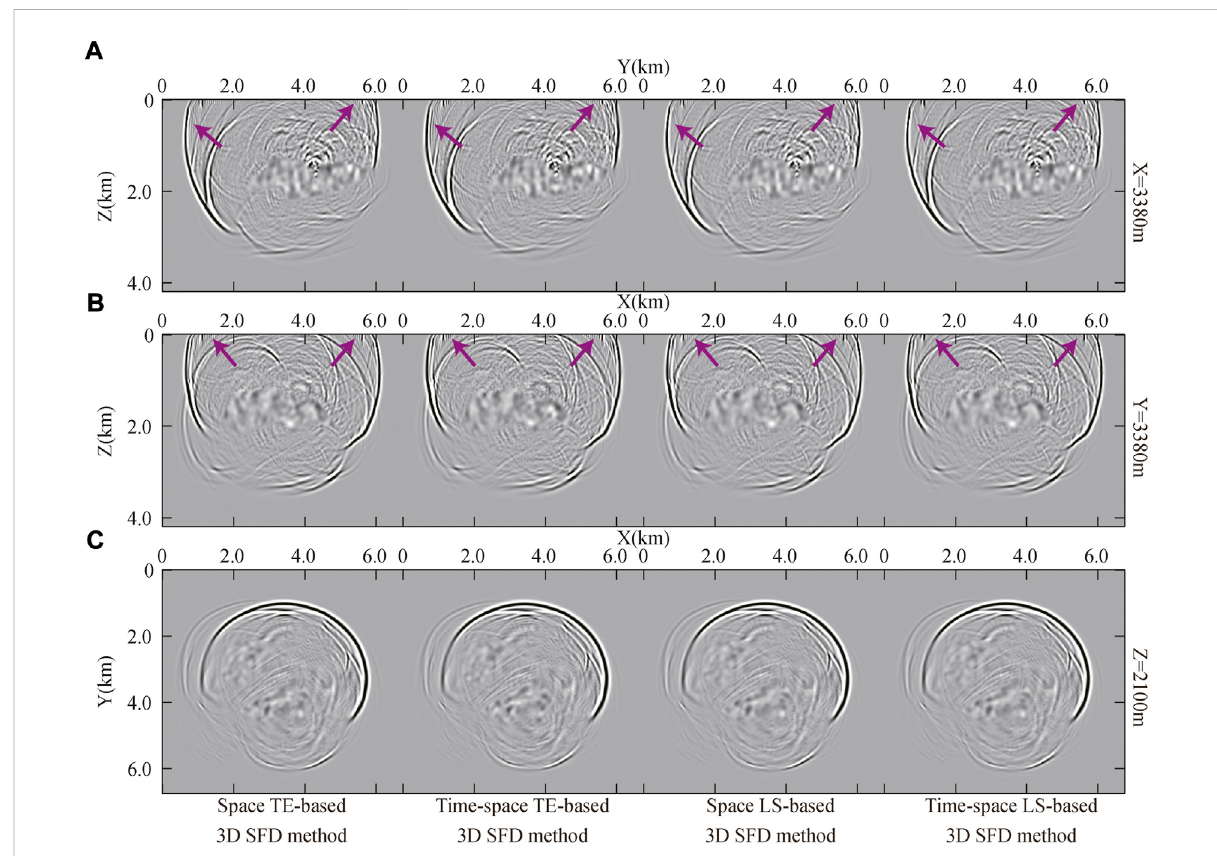
FIGURE 10 2D slices of the 3D snapshots ( t (cid:2) 1 . 6s) generated by different 3D SFD methods ( M (cid:2) 5) at the different positions for the 3D SEG/EAGE salt model. These subgraphs ( A – C ) indicate different positions and different 3D SFD methods listed in